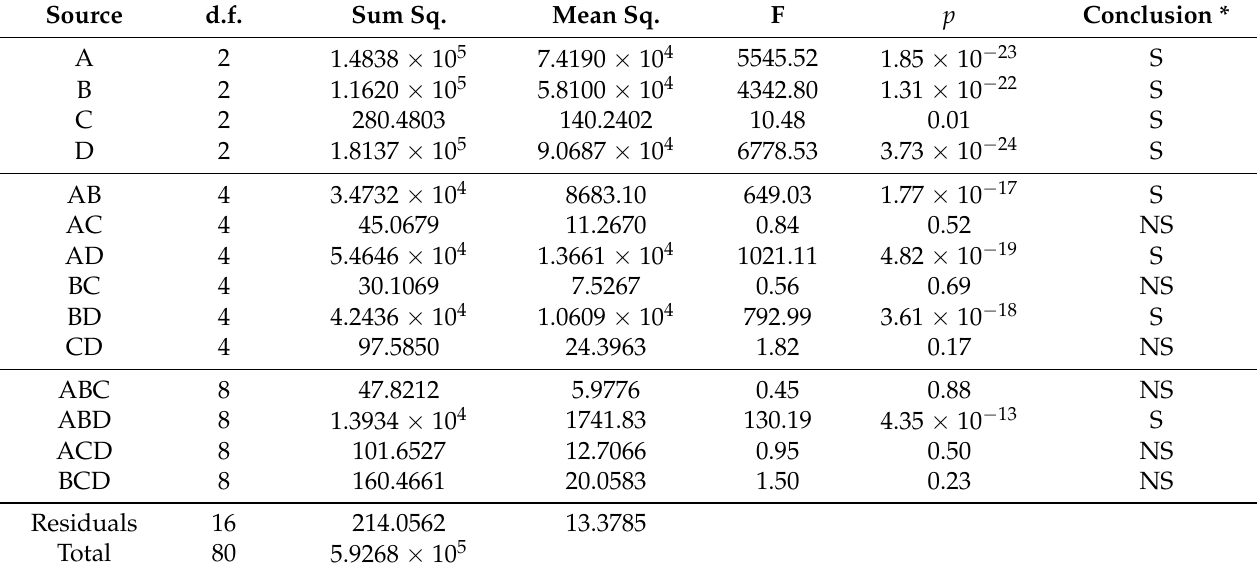
Table 6. Plateau stress results for the four-factor